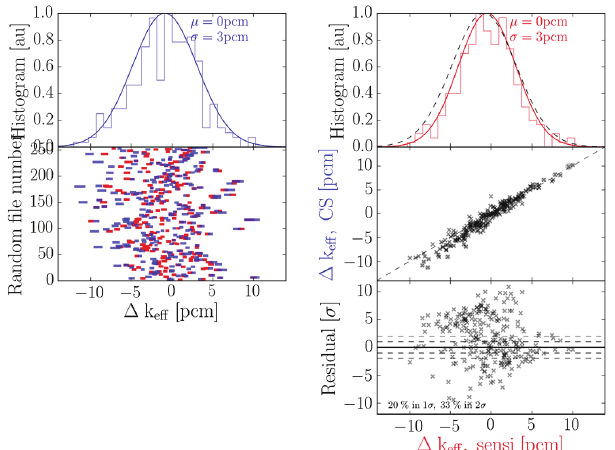
Fig. 10. k eff variation between random cross sections of 56 Fe. The columns present the results of TMC-CS (left) and TMC- sensi (right) as previously done.